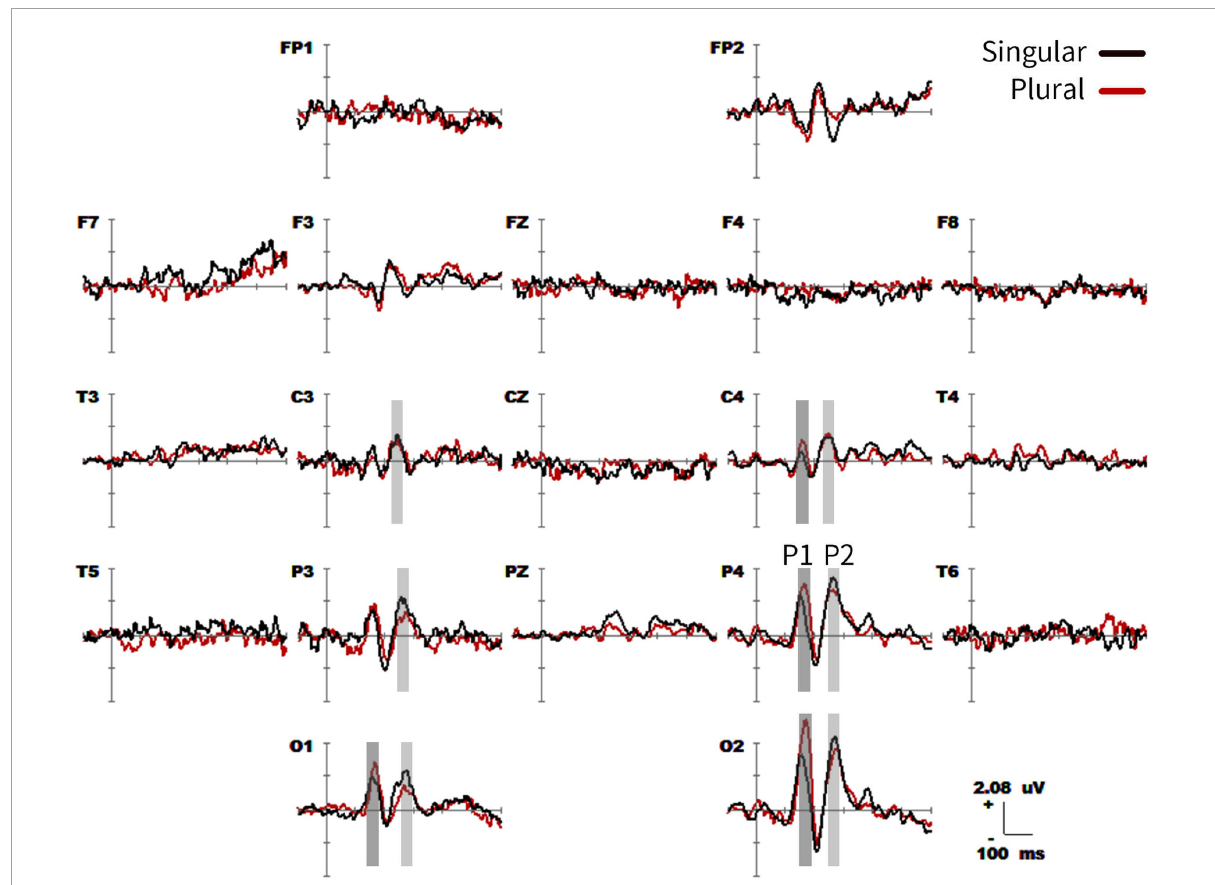
FIGURE2 Grand average event-related potential (ERP) waveforms (from –100 to 600 ms) are shown for 19 electrodes across singular (black traces) vs. plural (red traces) picture naming, from the 20 subjects. The baseline ERP measurement is the mean amplitude of a 100-ms pre-stimulus